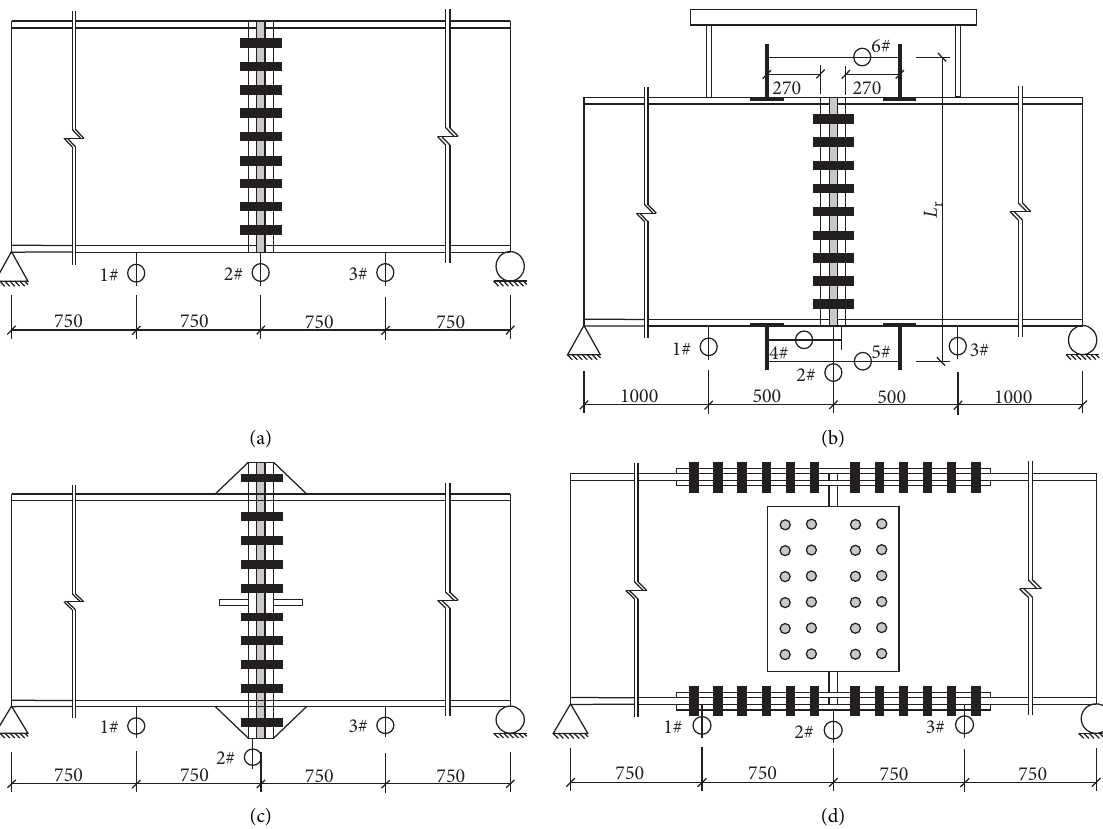
Figure 5: Layout of displacement transducers on the splicing joints of steel frame beams. (a) FLB specimens (midspan loading). (b) FLB specimens (pure bending). (c) EPB specimens. (d) CPB specimens.